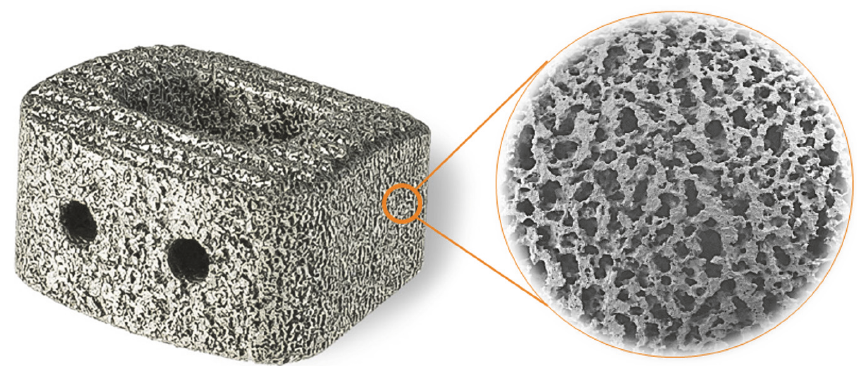
Figure 1: Commercially available porous Nitinol cage for anterior cervical intervertebral fusion and SEM image displaying the irregular pore